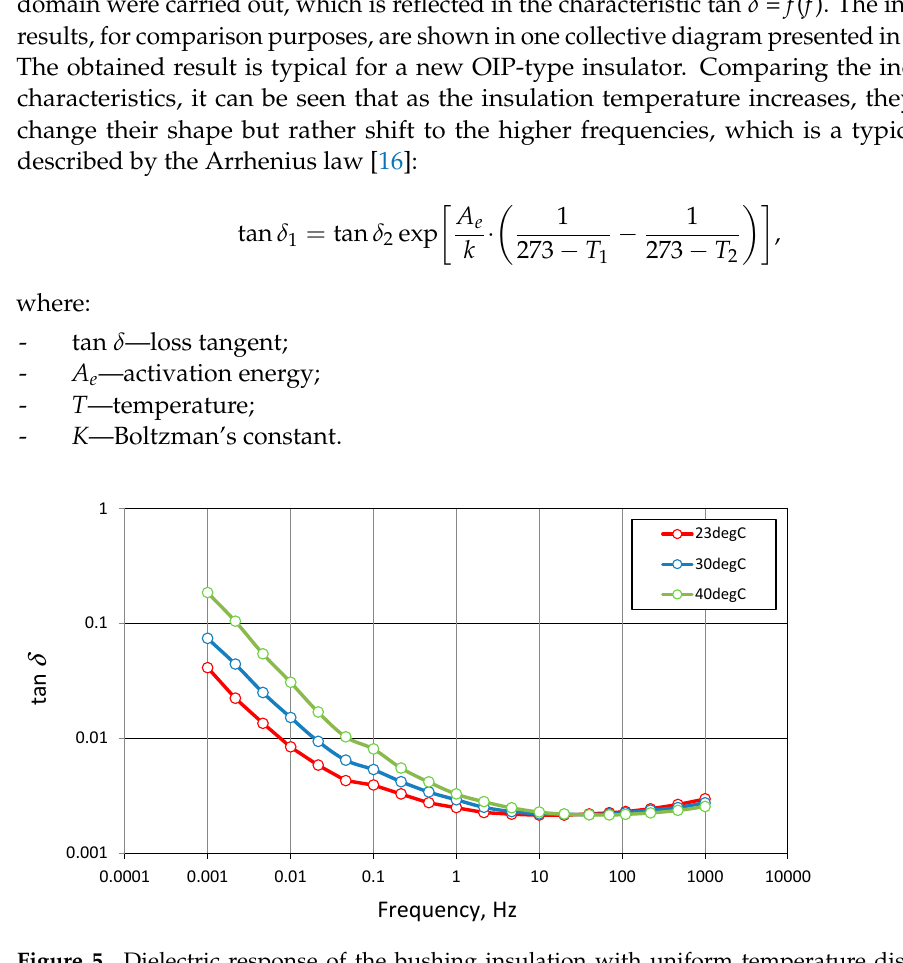
Table 2. Measurement of the bushing temperature at various points to check for uniform tempera- ture distribution; the markings of the measurement points are as shown in Figure 4a.